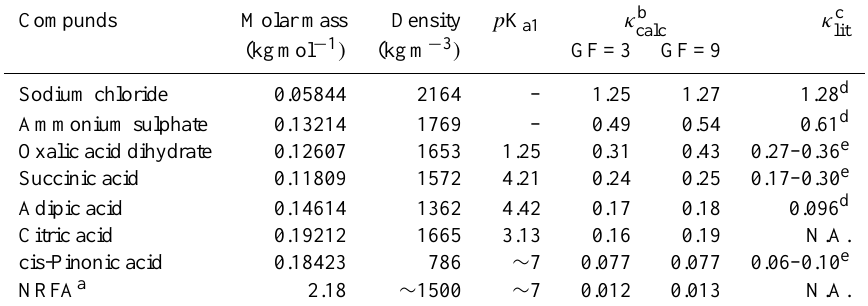
Table 5. Physical properties of the studied